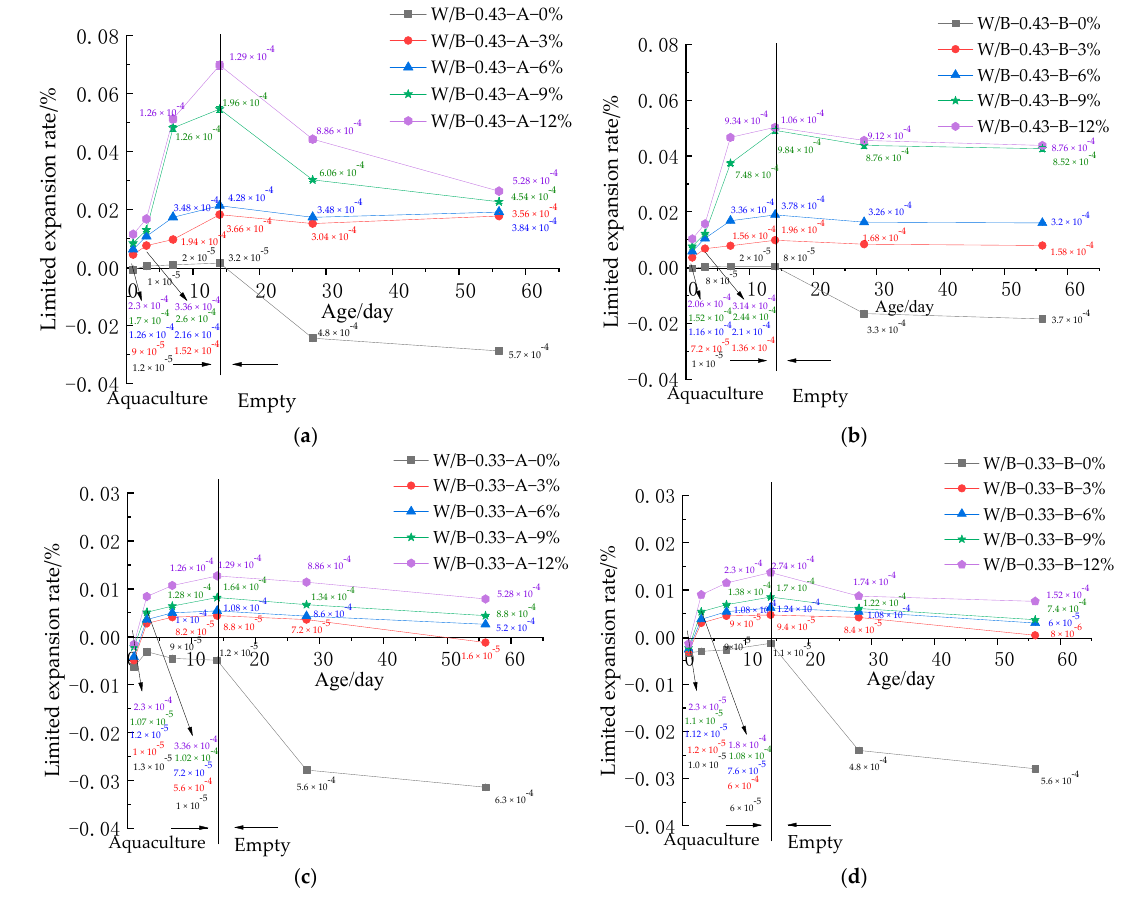
Figure 5. The limited expansion rate of concrete. ( a ) W/B-0.43 with 50% mineral admixtures, ( b ) W/B-0.43 with 60% mineral admixtures, ( c ) W/B-0.33 with 50% mineral admixtures, ( d ) W/B-0.33with 60% mineral admixtures.